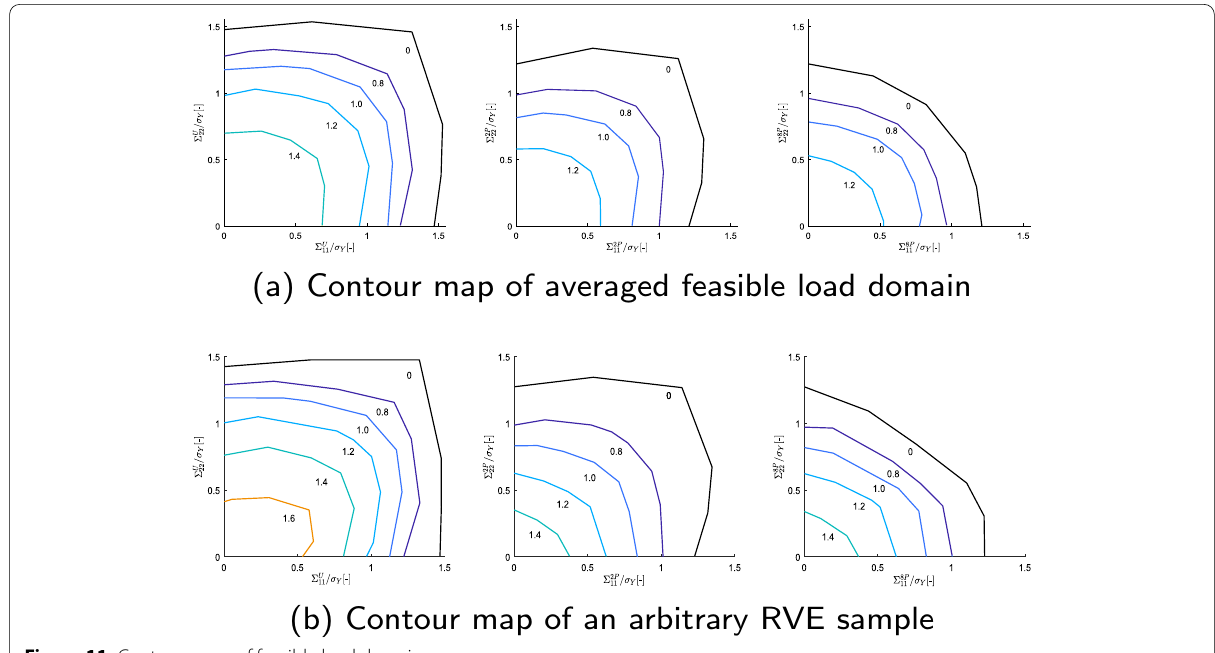
Figure 11 Contour maps of feasible load